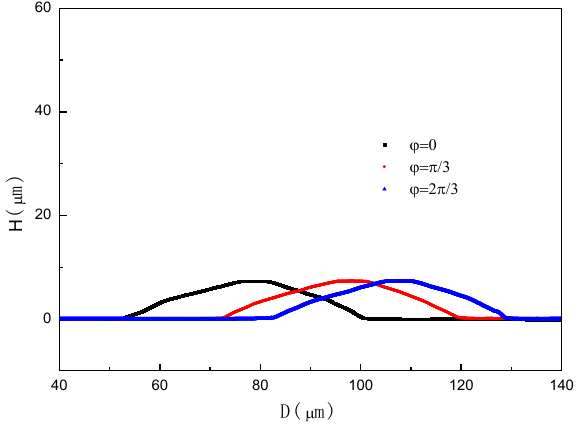
Figure 11. Measurements of three step height curves ( H ) in relation to the scanned path ( L ) with longitude ϕ = 0, π / 3, and 2 π / 3, respectively.